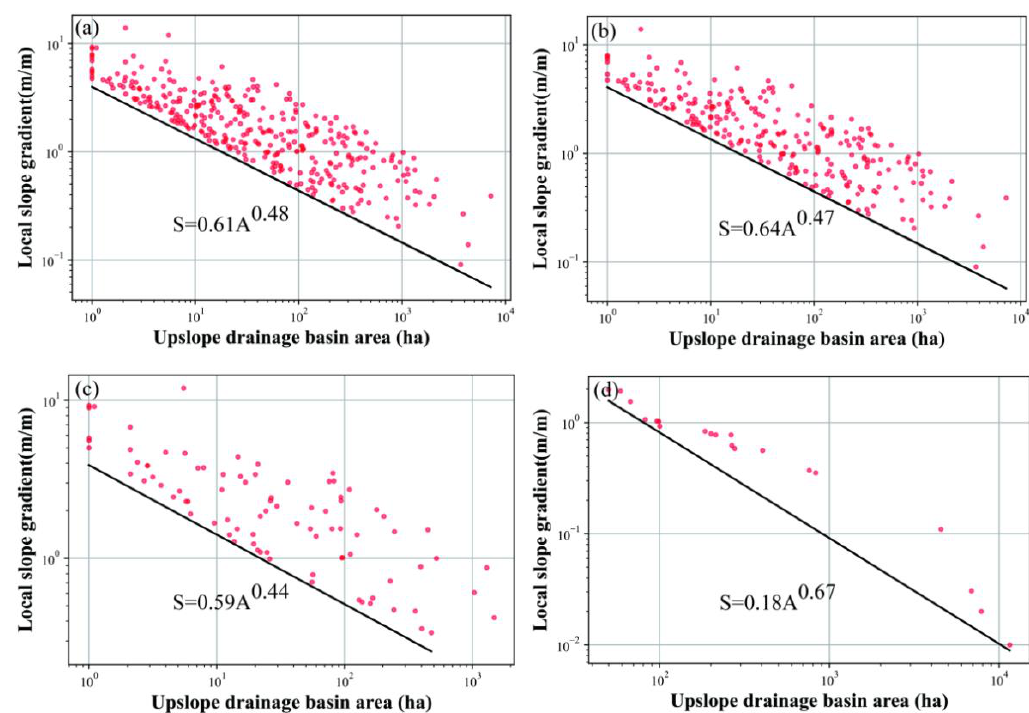
Figure 9. Relationships between local slope (S) of gully head, and upslope drainage area (A) and its slope – drainage area thresholds for gully initiation. ( a ) S – A under all land-use types (n = 365), ( b ) S – A under shrubland (n = 262), ( c ) S – A under grassland (n = 83), and ( d ) S – A under cropland (n = 20).